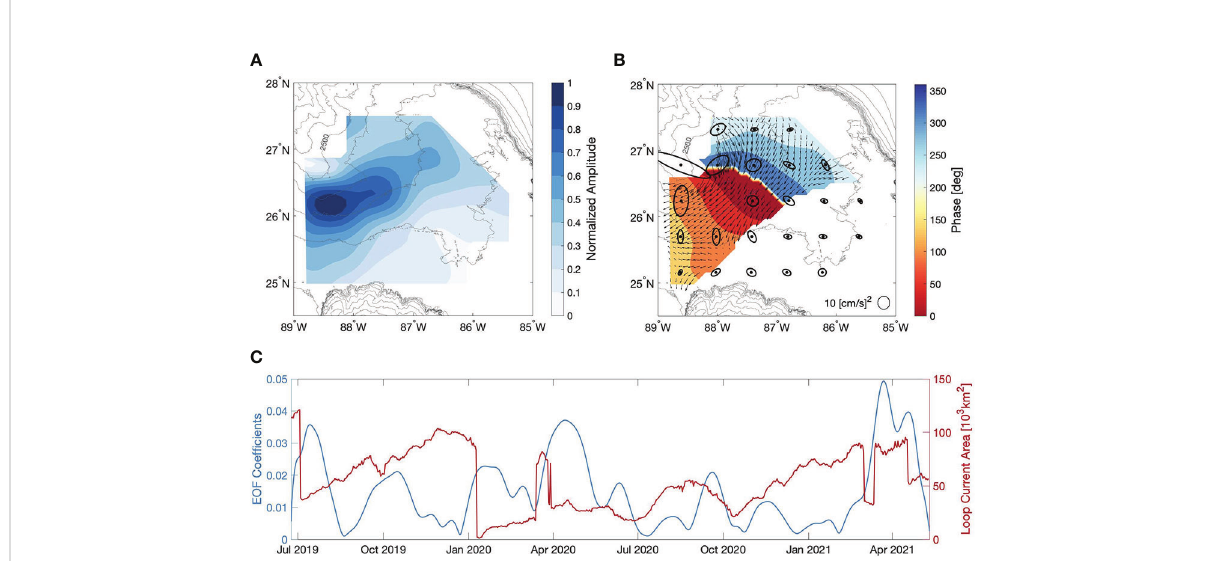
FIGURE 7 Normalized spatial amplitude (A) and phase in degrees (B) derived from CEOF of 1/20 – 1/10 day – 1 band-passed reference sea surface height, SSH ref , during the full two year deployment. Phase is plotted for regions where the spatial amplitude is greater than 0.3. Propagation direction indicated by the phase gradient (arrows). CPIES locations are marked by closed black circles surrounded by 1/20 - 1/10 day -1 band-passed variance ellipses. Bathymetry is contoured every 250 meters. CEOF amplitude time series ( C ; blue) and LC Area ( C ; red) derived from satellite